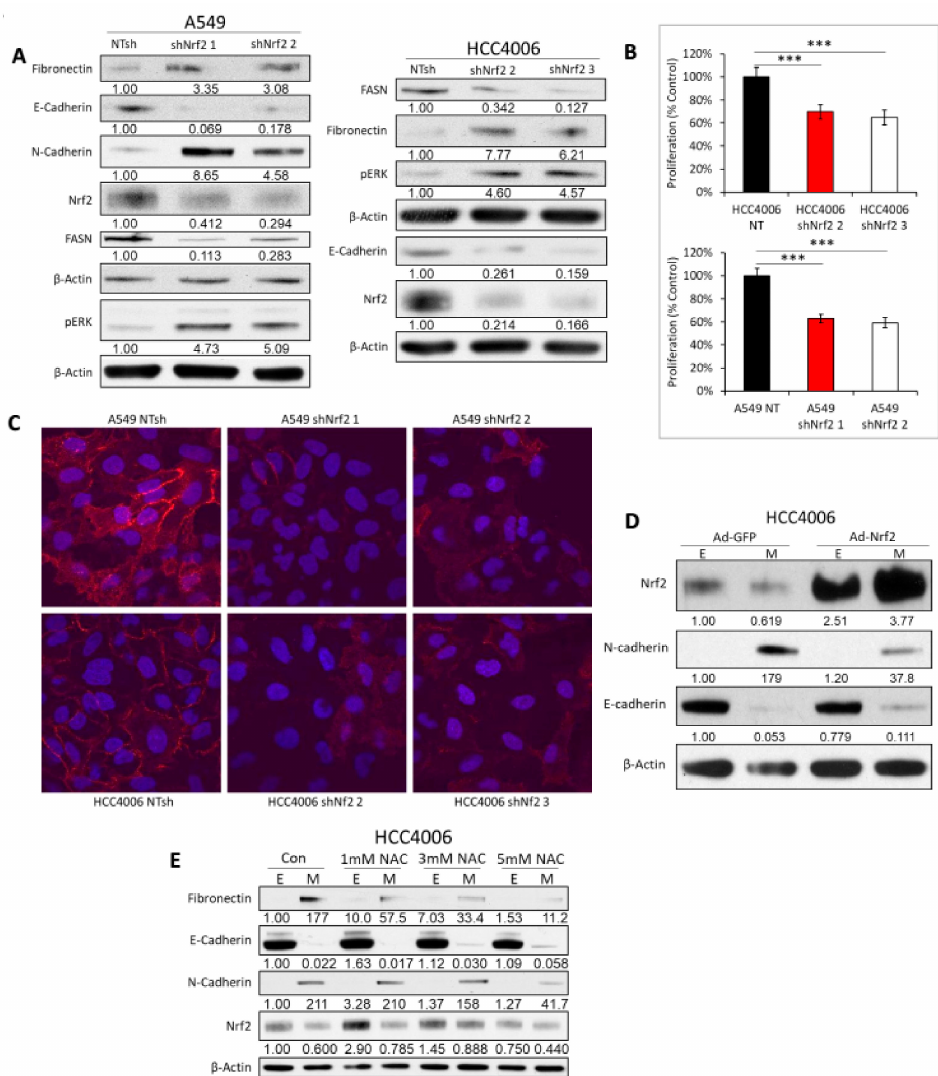
Figure 5. Nrf2 promotes an epithelial phenotype and antagonizes the mesenchymal state. ( A ) Nrf2 knockdown in A549 and HCC4006 leads to an increase in mesenchymal marker expression and a decrease in epithelial marker expression, as well as a decrease in FASN and increase in pERK by immunoblot. ( B ) Nrf2 knockdown in A549 and HCC4006 decreases cell proliferation over 72 h ( p < 0.05 *; p < 0.01 **; p < 0.001 ***). ( C ) Nrf2 Knockdown in A549 and HCC4006 causes loss of E-cadherin (red) from the cell membrane by IF, where nuclei are stained with DAPI (blue). ( D ) When Nrf2 is overexpressed in HCC4006, mesenchymal marker expression decreases (N-cad) while the epithelial marker (E-cad) increases by immunoblot. ( E ) In HCC4006, treatment with 1, 3, 5 mM NAC over the course of 72 h, a loss of M markers and gain of E markers is seen in the M